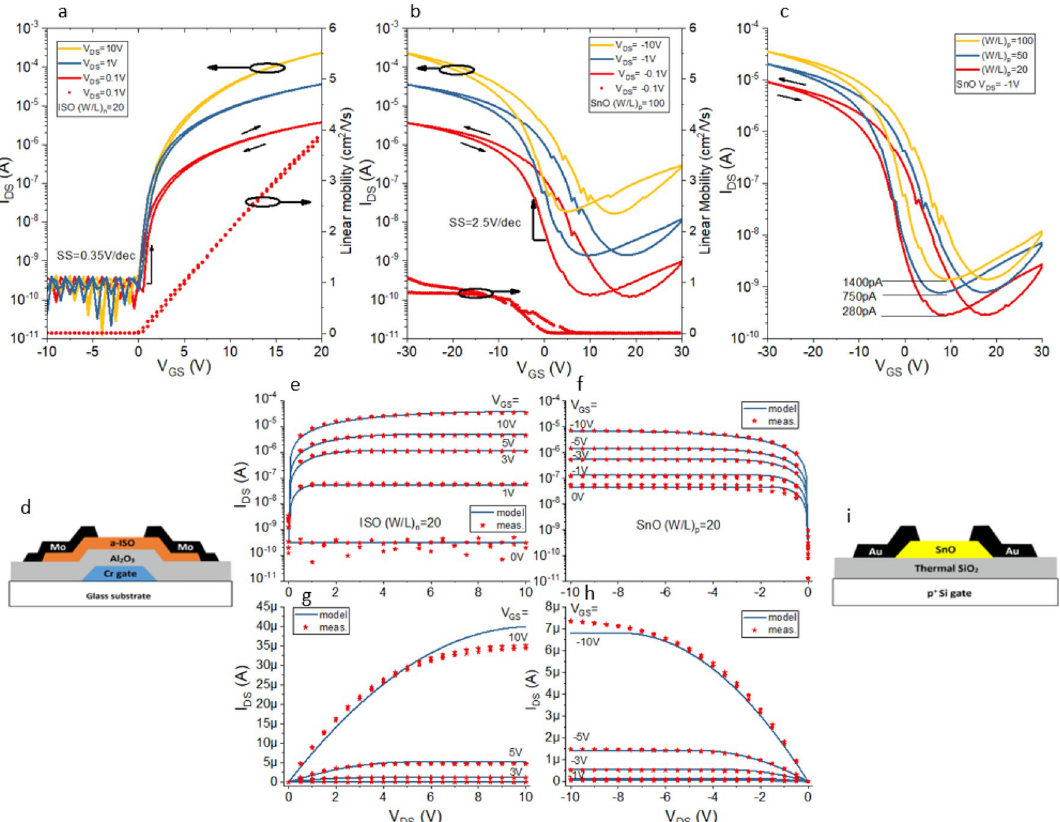
Figure 2. Experimentally measured transfer characteristics and linear mobility of ( a ) a-ISO TFT and ( b ) SnO TFT. Transfer characteristics of SnO TFT with different W/L ratios ( c ). Output characteristics (red) and modelled curves (blue) of the a-ISO TFT and the SnO TFT ( b , d ) in log ( e , f ) and linear scales ( g , h ). Schematic cross section of ( d ) the a-ISO TFT and ( i ) SnO